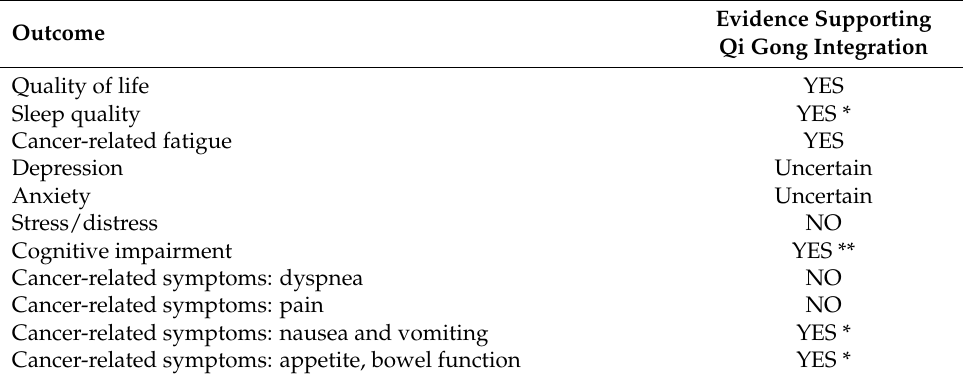
Table 4. Summary of evidence about psychological and clinical outcomes.